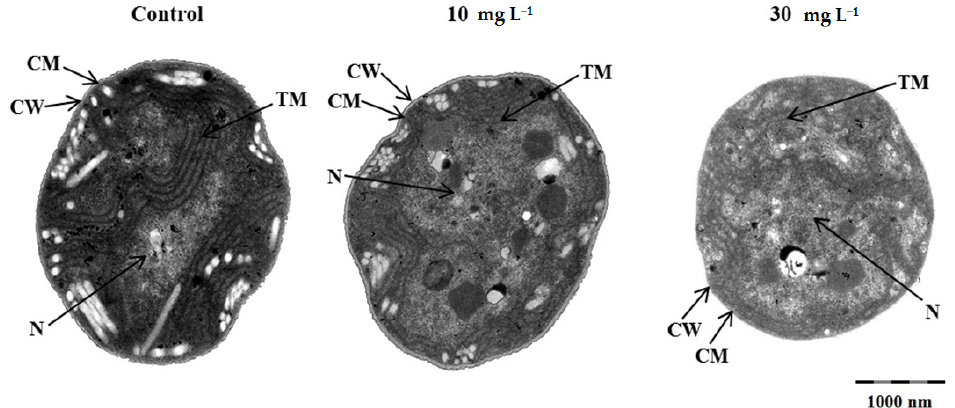
Figure 4. Effects of [Hmim]Cl on the ultrastructure of M. aeruginosa PCC 7806 after 48 h of exposure at 10 and 30 mg L − 1 , CW: cell wall; CM: cell membrane; TM: thylakoid membrane; N: nucleoid.